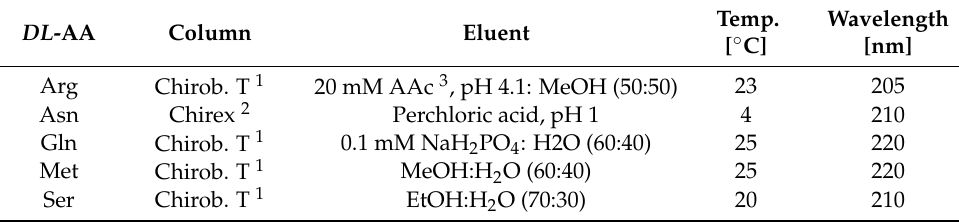
Table 8. Separation conditions of the tested AAs for the analysis of the racemization samples. DL -AA Column